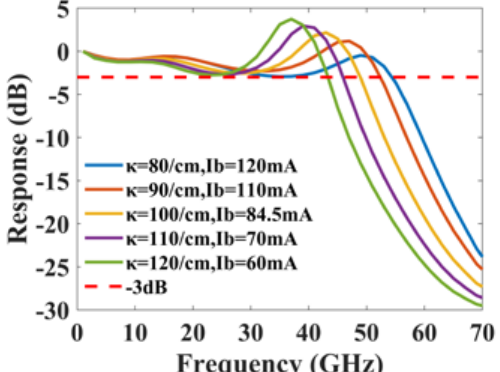
Figure 12. The effect of the errors between the front and rear cavity lengths and the design value on the modulation response: ( a ) L r = 285 µ m; ( b ) L r = 265 µ m.